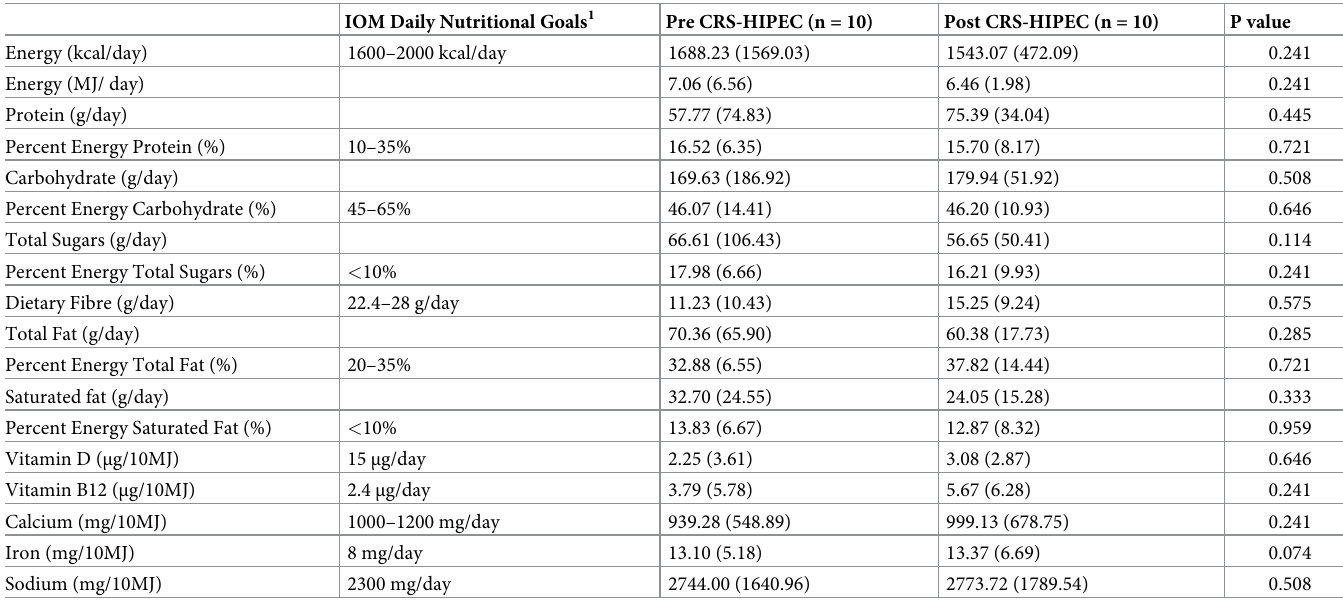
Table 4. Nutrient intakes (Foodbook24) pre- and post-